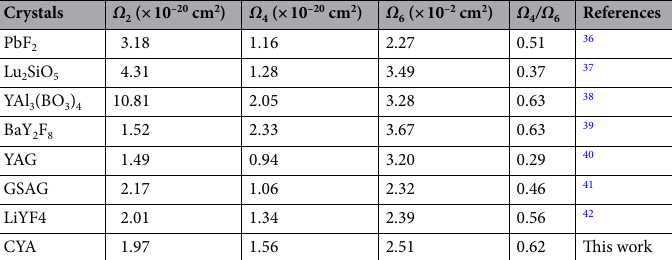
Table 3. J–O parameters of Dy 3+ -doped laser